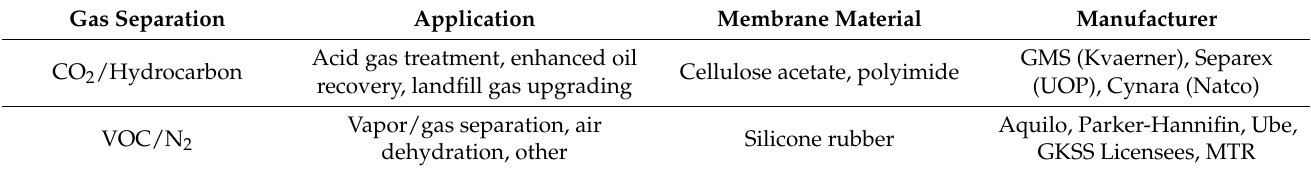
Table 2. SWM gas separation applications corresponding to materials and manufacturers [9].